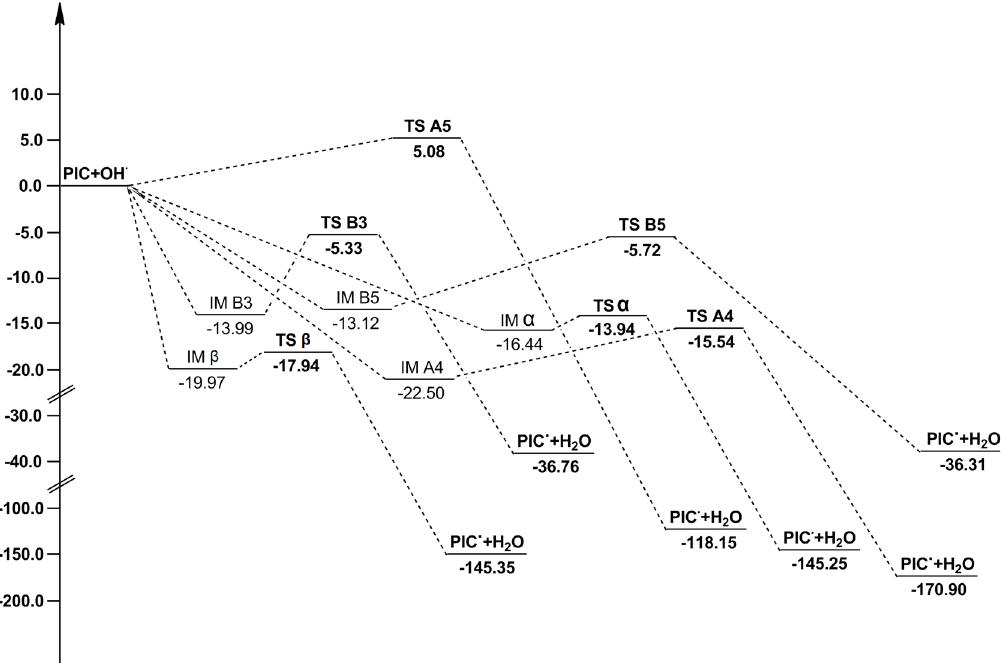
Fig 4. The potential energy surfaces of the reactions of PIC with (cid:129) OH in the gas phase. The relative energies (in kJ/mol) were calculated at the M05-2X/ 6-311++G(d,p) + ZPE level. To facilitate comparison, the energy of the reactants are set to